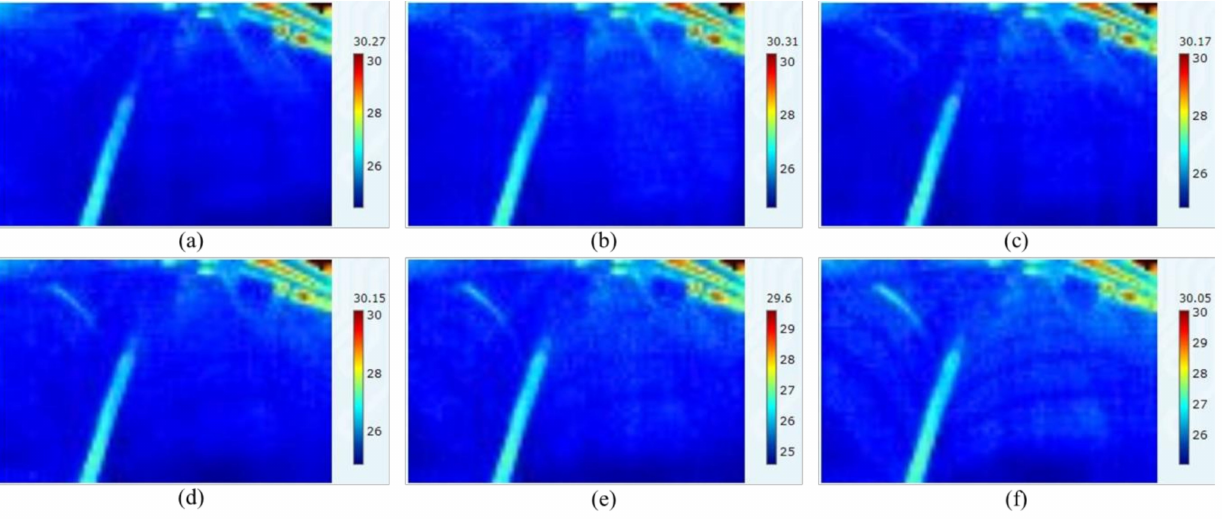
Figure 23. Sequentially, ( a ) 5%, ( b ) 10%, ( c ) 15%, ( d ) 20%, ( e ) 25%, ( f ) 30% of the thermal image. The left is a thermal image, and the right is a temperature scale. ITSC appears in the upper left corner of the image.